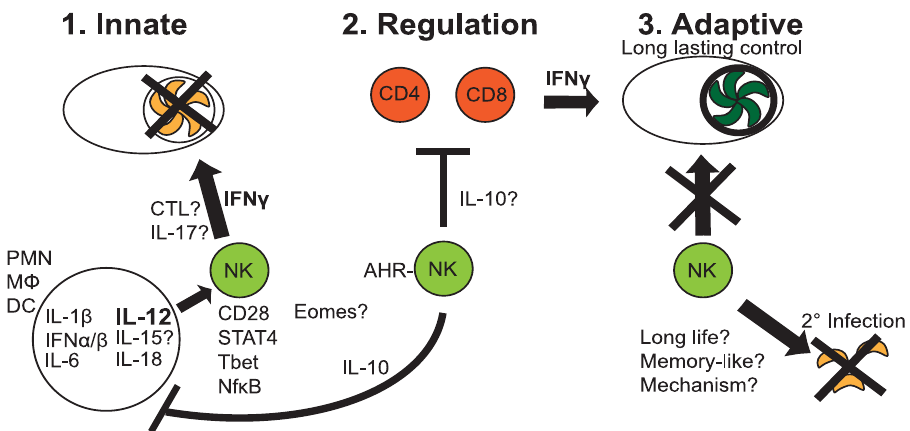
Fig 1. Multiple roles for NK cells during T . gondii infection. Natural killer (NK) cells function in different phases of immunity in response to parasite infection. Step 1: Innate . During the innate response, T . gondii infection stimulated production of inflammatory cytokines IL-1 β , IFN α / β , IL-6, IL-12, IL-15, and IL-18, driving NK cell production of IFN γ . This results in early control of parasite infection by targeting intracellular parasites. IL-6 can stimulate NK cell IL-17 production. The importance of NK cell IL-17 is not well understood. Cytotoxic (CTL) response by NK cells is also induced; however, the importance of this function for control of acute parasite infection is not well known. Other factors important for NK cell responses include CD28, STAT4, Tbet, and Nf κ B family members (cRel, p50). Eomesodermin (Eomes) role is unclear. Step 2: Regulation . NK cells produce IL-10 and regulate innate responses by down-regulating IL-12 and possibly other cytokines. This is aryl hydrocarbon receptor (AHR)-dependent. Whether NK cell IL-10 can impact CD4 and CD8 T cell responses is not known. Step 3: Adaptive . NK cells can participate in adaptive immunity as memory-like cells. NK cells may be important for (2°) secondary T . gondii infections. Whether NK cells that experience T . gondii infection early live long-term or develop memory-like features and the mechanisms behind these cell-intrinsic fates are